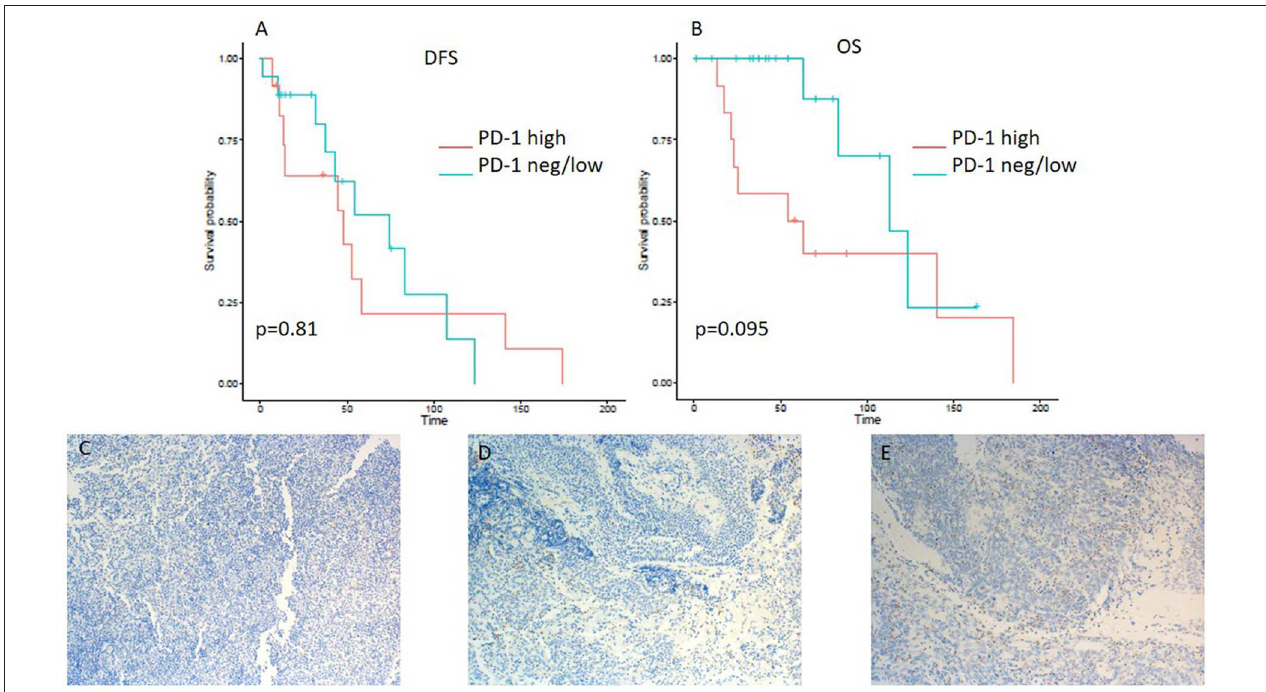
FIGURE 5 | Kaplan–Meier curves for DFS (A) and OS (B) according to PD-1 expression on tumor infiltrating lymphocytes (TILs) (neg/low vs. high). Representative images of PD-1 expression on TILs: (C) negative, (D) low, and (E) high (x100 magnification). Log-rank tests were performed, and p -values are depicted.